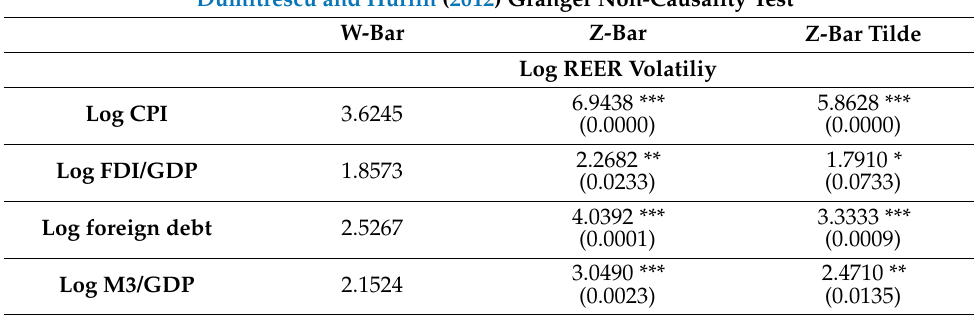
Table 12. Granger non-causality test